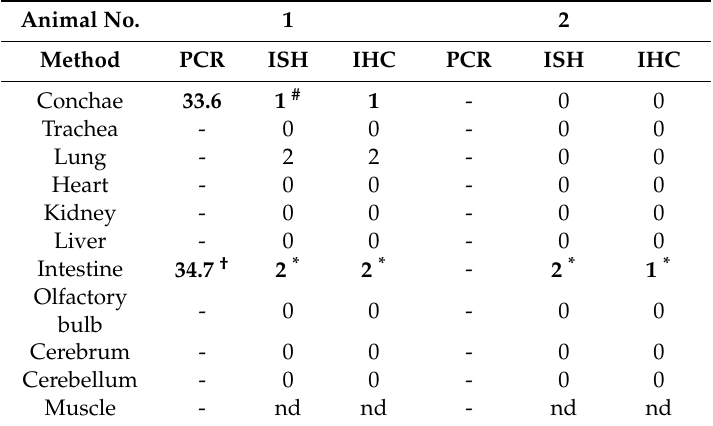
Table 1. Distribution of viral RNA and matrix protein antigen signals in H18N11-infected bats at 4 dpi. Animal No. 1 2 Method PCR ISH IHC